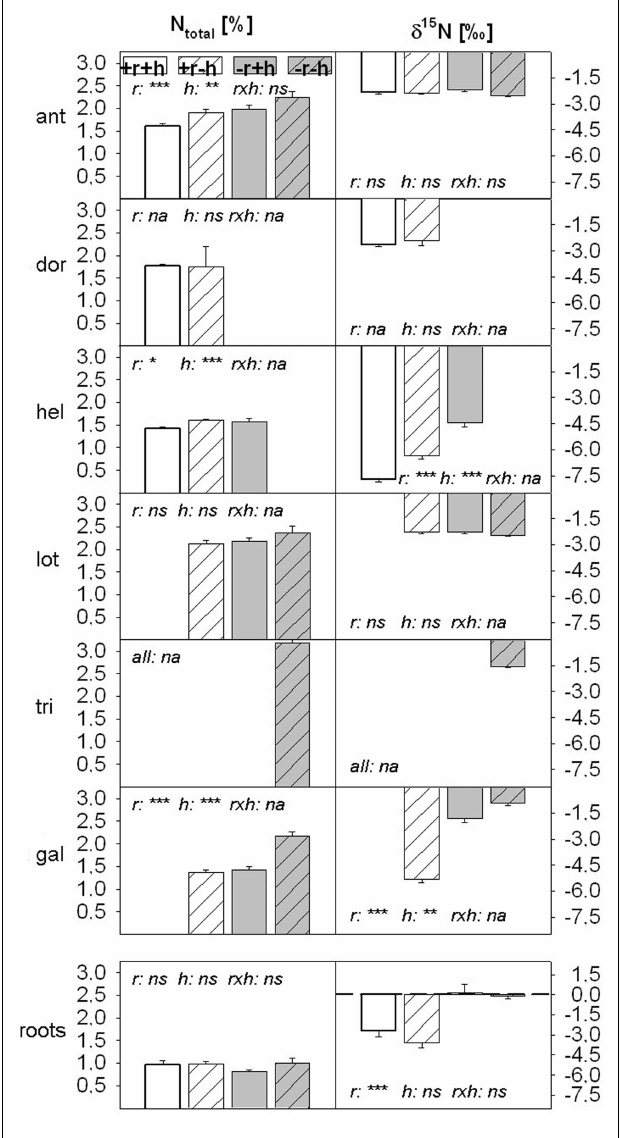
FIGURE 4 | N concentration [%] and δ 15 N in plant leaves of all six species (three target calcareous grassland and three mesic species) and in root samples (species not identified) in the four restoration treatments. Values are means ± 1 SEM (plant: n = 6 – 42, except for D. germanicum in + r − h treatment: n = 2; root: n = 8). Data for some species in some treatments are missing, as the species was not growing in that treatment (see Table 2 ). Restoration treatments: with topsoil removal and hay transfer ( + r + h , white bars), with topsoil removal and without hay transfer ( + r − h , white striped bars), without topsoil removal and with hay transfer ( − r + h , gray bars), without topsoil removal and without hay transfer ( − r − h , gray striped bars).Target species: ant = Anthyllis vulneraria , dor = Dorycnium germanicum , hel = Helianthemum nummularium (two legume and one non-legume species, respectively) and mesic species: lot = Lotus corniculatus , tri = Trifolium pratense and gal = Galium mollugo (two legume and one non-legume species, respectively). Significant effects of restoration treatments ( r = topsoil removal, h = hay transfer, r × h = interaction between both factors) on plant N parameters are shown as * p < 0.05, ** p < 0.01, *** p < 0.001; ns, not significant; na, not available; p -values from ANOVA (Type III Sum of Squares, compare to Table 3C ).